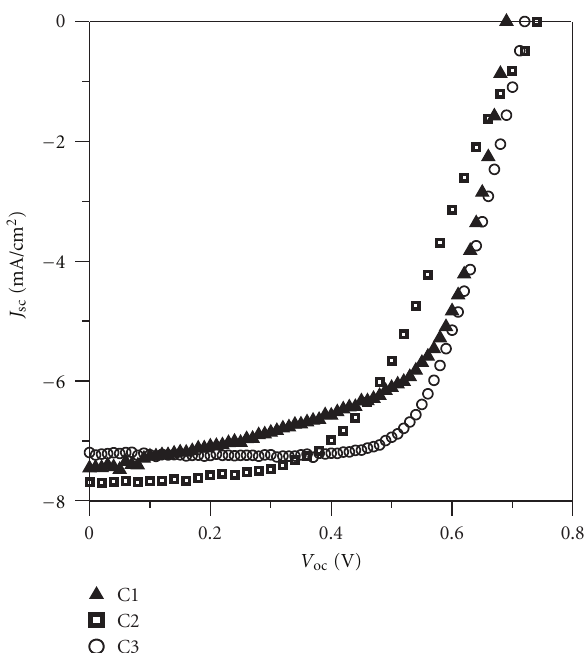
Figure 6: Photocurrent-voltage curves for the DSCs fabricated with di ff erent counter